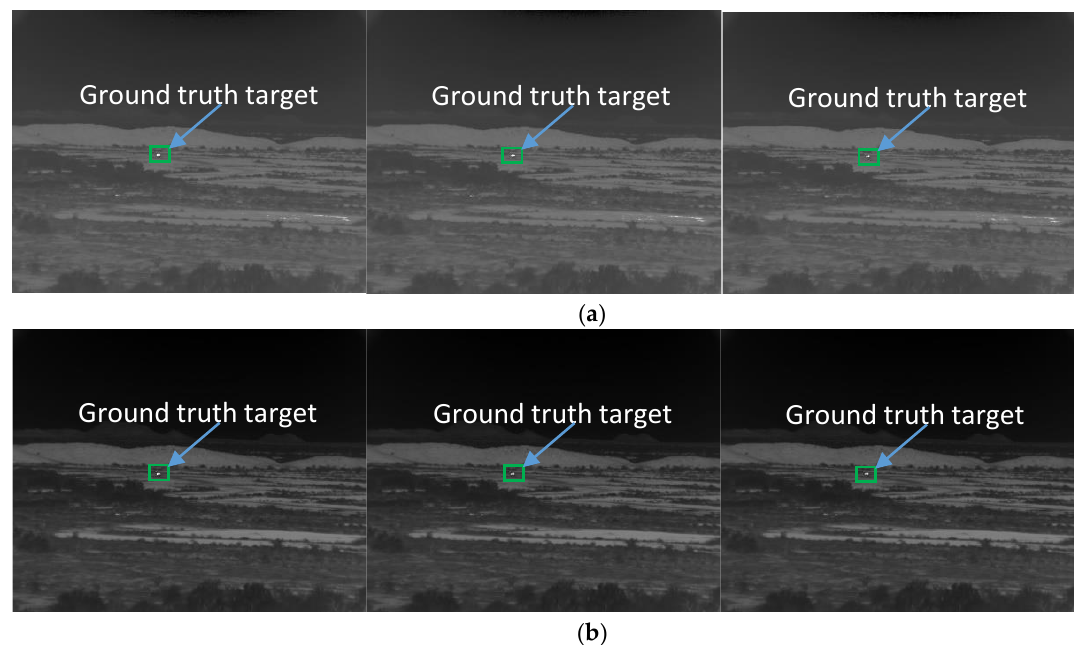
Figure A8. Three frames from 4000 m for Approach 1 and 3a. ( a ) Approach 1; ( b ) Approach 3a.